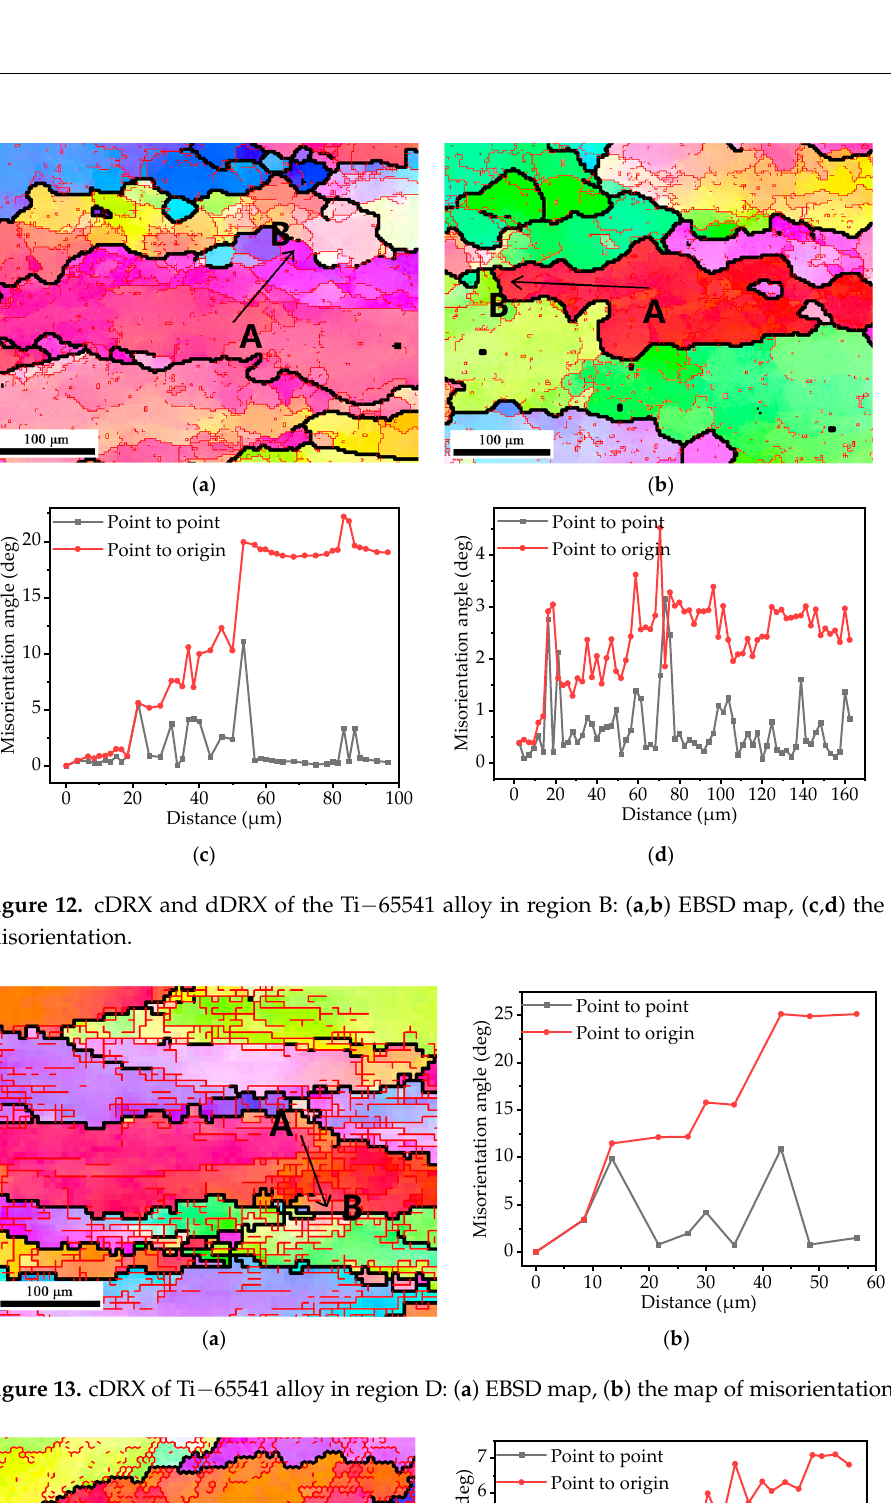
Figure 13. cDRX of Ti − 65541 alloy in region D: ( a ) EBSD map, ( b ) the map of misorientation.